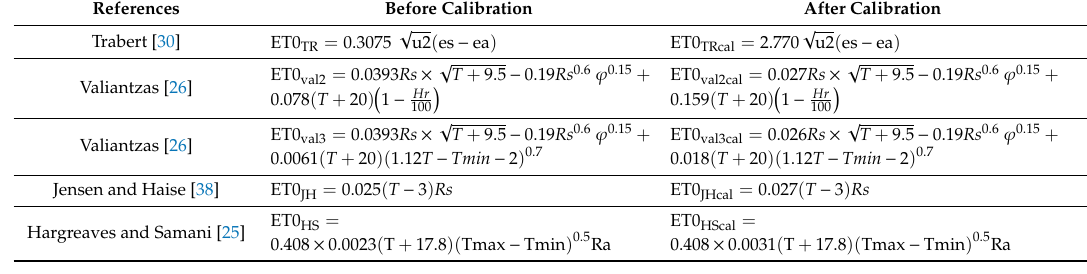
Table 4. Best reference evapotranspiration (ET 0 ) estimation methods before and after calibration.